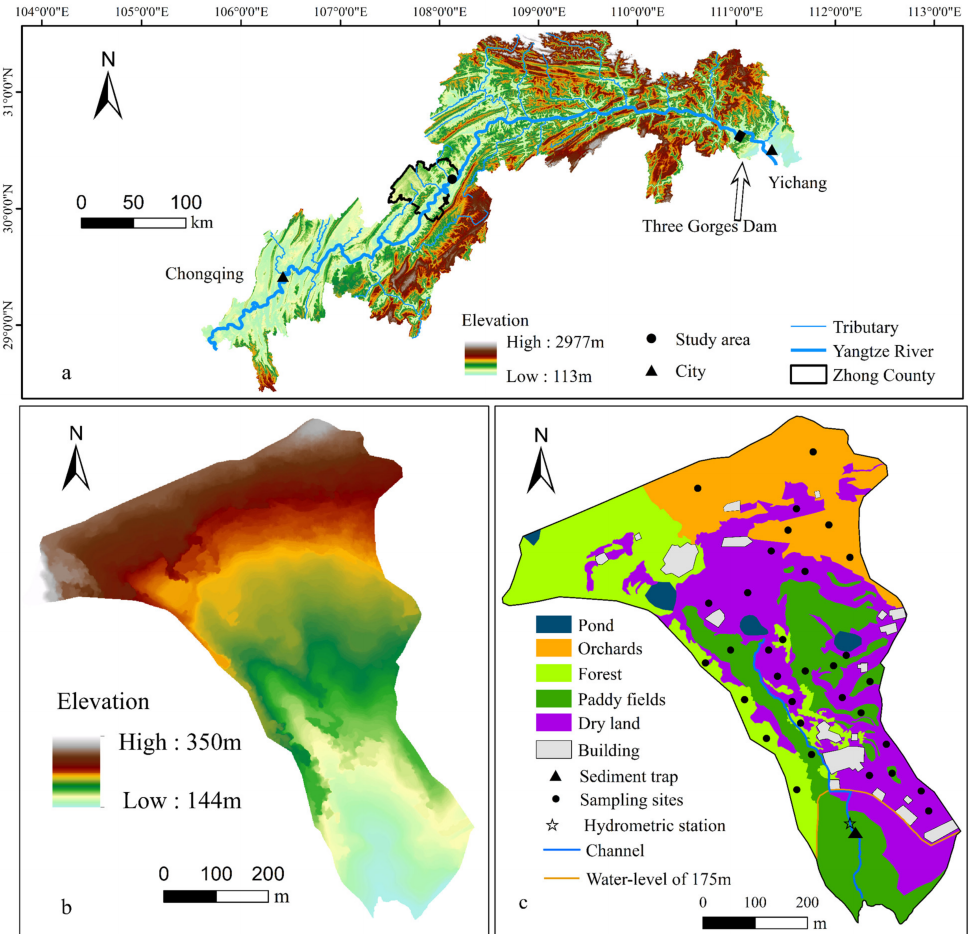
Figure 1. ( a ) Elevation map of the Three Gorges Reservoir Region displaying Shipanqiu catchment. ( b ) Elevation map of Shipanqiu catchment. ( c ) Distribution of land-use types and soil sampling sites in Shipanqiu